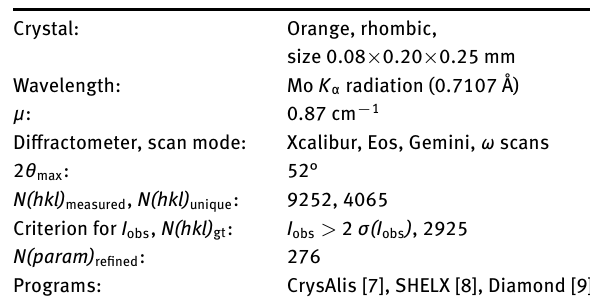
Table 1: Data collection and handling.